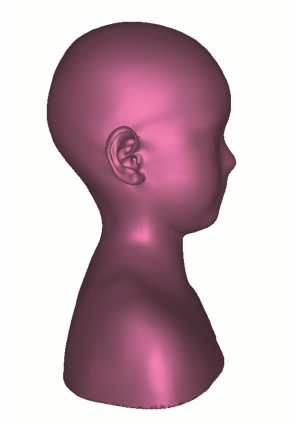
Figure 4. Exemplary anonymized 3D-surface mesh of one